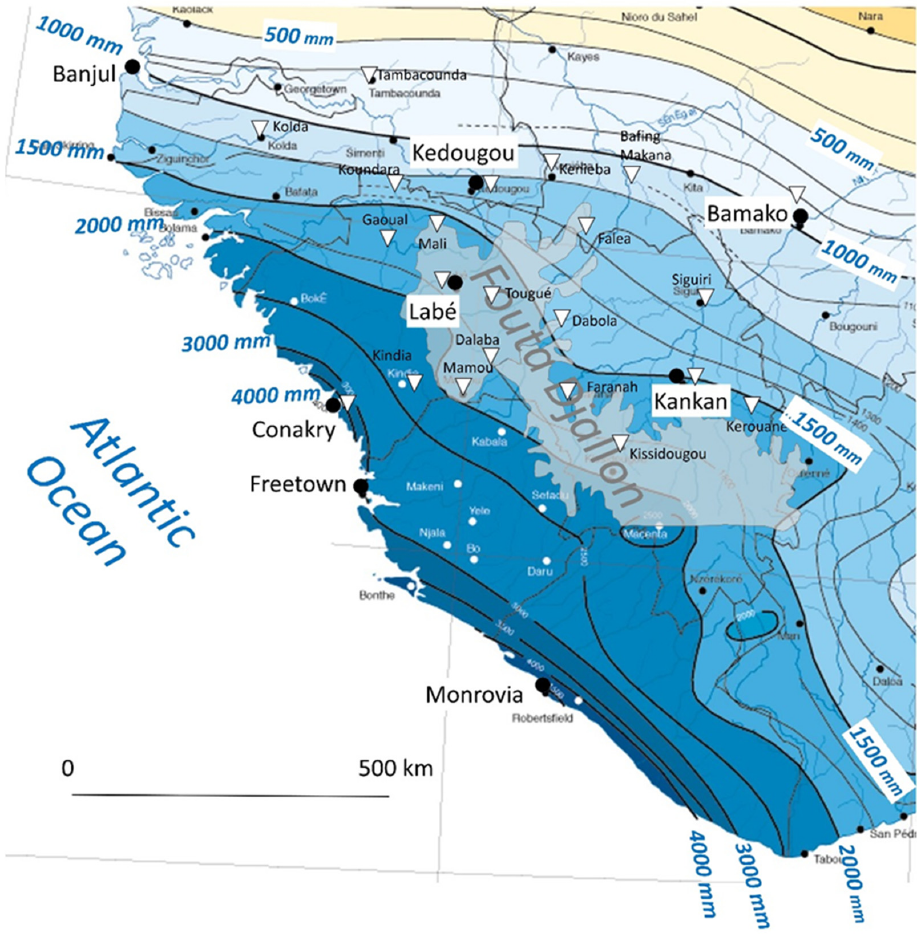
Figure 4. Rainfall spatial distribution (1950–2000) [1] and location of rain gauges (white triangles) used to unskew CHIRPS data.